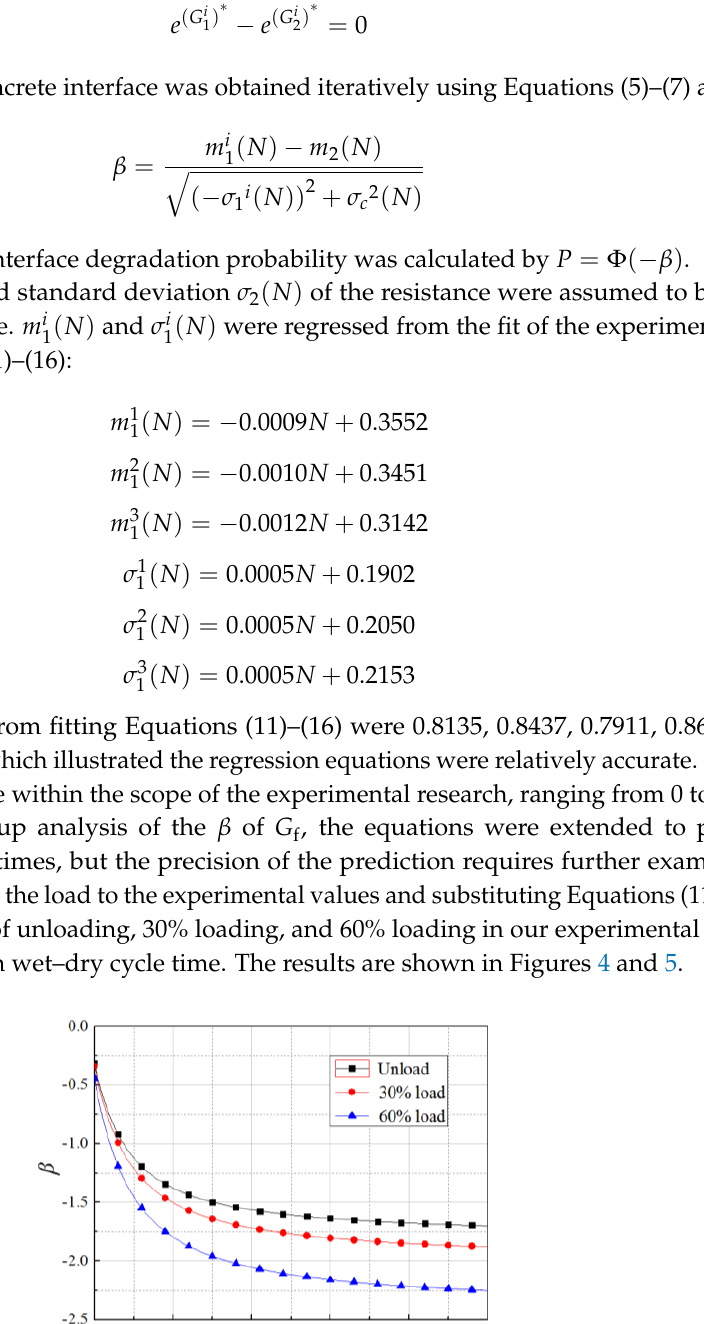
Figure 5. Change of P with wet–dry cycles. As shown in the figures, for all the specimens under a sustained load and those without sustained loading, the change in the β of G f with wet–dry cycle time were divided into two stages,